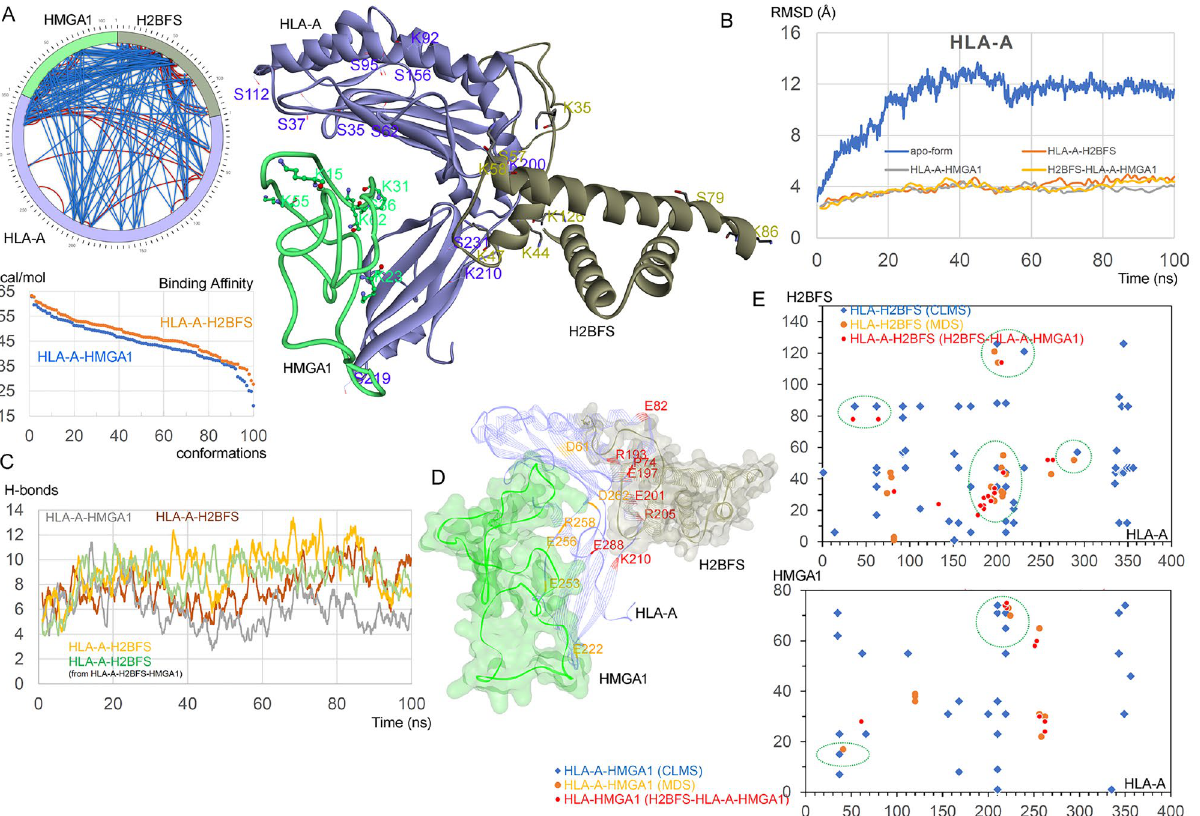
Figure 8. Conformational dynamics of the possible network between H2B (H2BFS)-HLA-A, HMGA1- HLA-A and H2B-HLA-A-HMGA1 complexes. (A) The left panel represents a 2D map (generated in SIM-XL program 29 ) of intramolecular (red) and intermolecular (blue) cross-links (cross-link score cut-off was set to 3.5). In addition, the identified cross-link residues were labeled on the H2B, HLA-A, and HMGA1 protein structures. The binding conformations of these proteins were retrieved by the docking pipeline implemented in the MOE package. The bottom left panel shows different possible conformations of the H2B-HLA-A and HMGA1- HLA-A complexes, varying in their protein–protein binding affinity (GBVI/WSA dG; kcal/mol). (B) The root- mean-square deviation (RMSDs) of atomic positions (excluding hydrogen atoms) of each protein structure. (C) Intermolecular protein–protein hydrogen-bond interactions from different simulated complexes, a particular interaction lasting ≥ 10 ns were considered. The h-bond donor–acceptor atom cutoff distance was set to 3.5 Å, and the donor-H-acceptor angle cutoff was set to ≥ 160°–180°. (D) Labeled residues forming protein–protein interactions from HLA-A with respective partners with occupancy ≥ 20 ns, retrieved from the HLA-A-H2B and HLA-A-HMGA1 simulated complex. The protein structure represents averaged structures from 100 ns MDS. (E) Differently identified cross-links between the HLA-A-H2B and HLA-A-HMGA1 complexes based on the interaction site K or S between two peptides, compared with the interactions traced from 100 ns MS